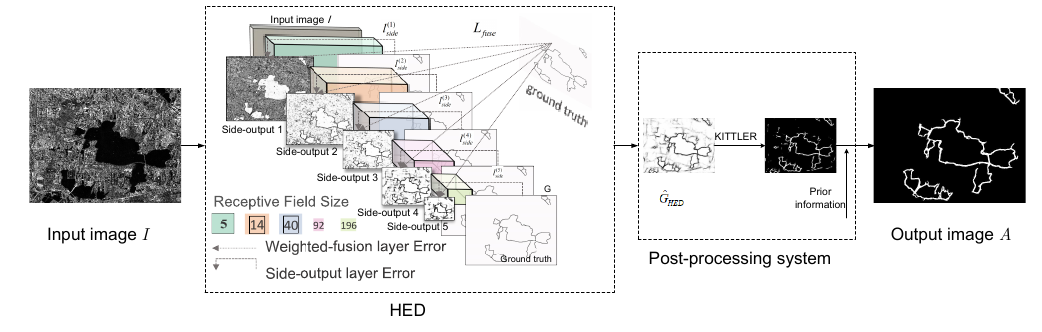
Figure 1. Framework of the modified